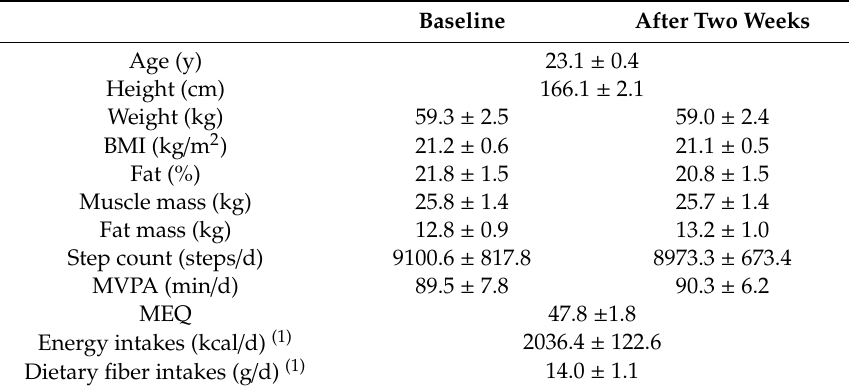
Table 4. Study participants characteristics ( N =